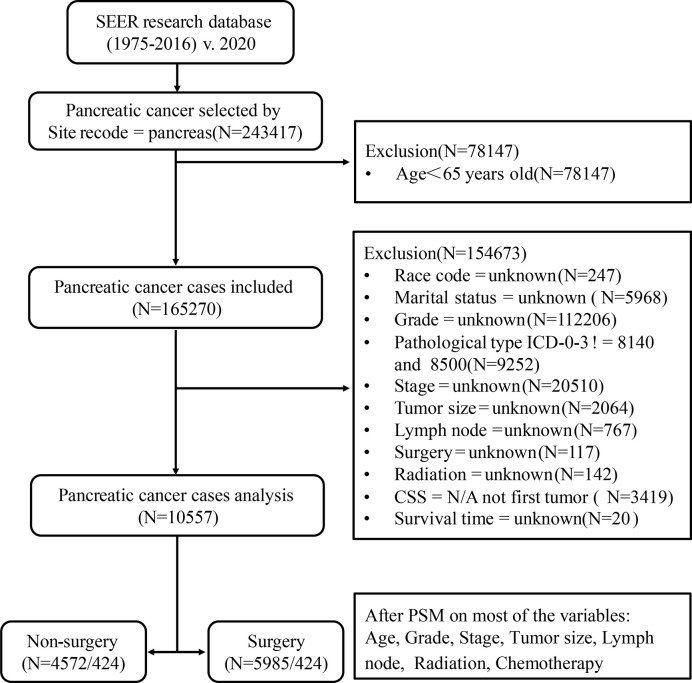
Flow chart of data selection in this study. 8,140, pancreatic acinar cell carcinoma (PACC); 8,500, pancreatic ductal adenocarcinoma (PDAC).